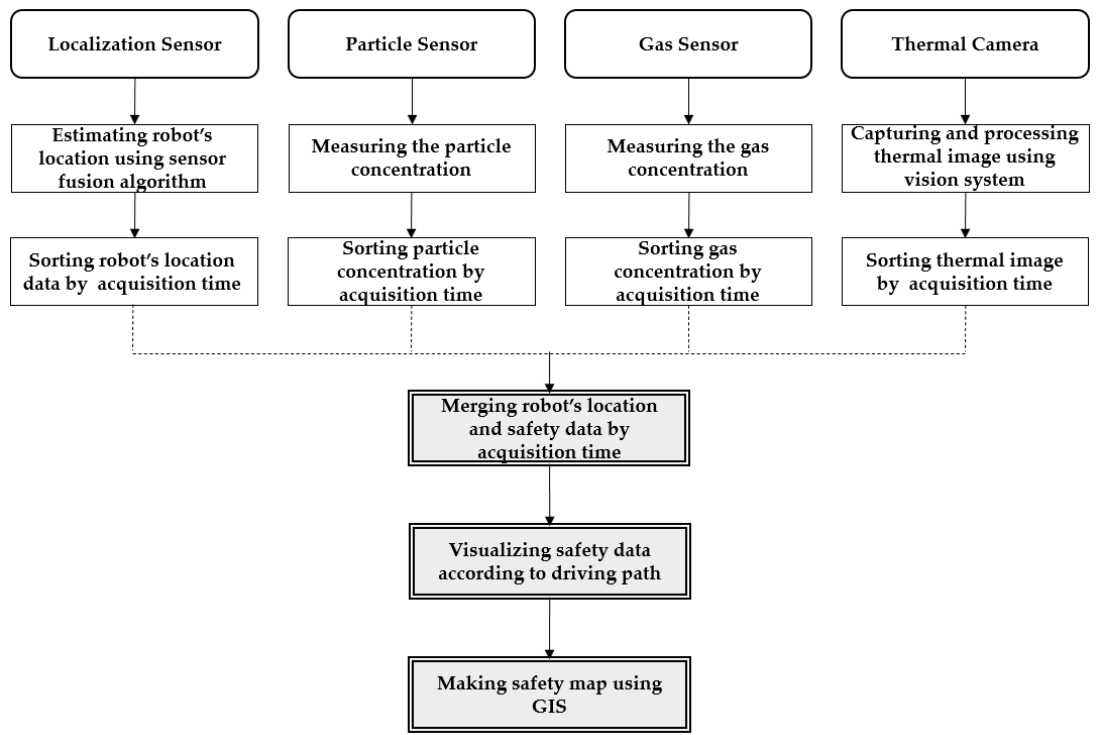
Figure 7. Processing diagram of the environmental mapping system to visualize the data.